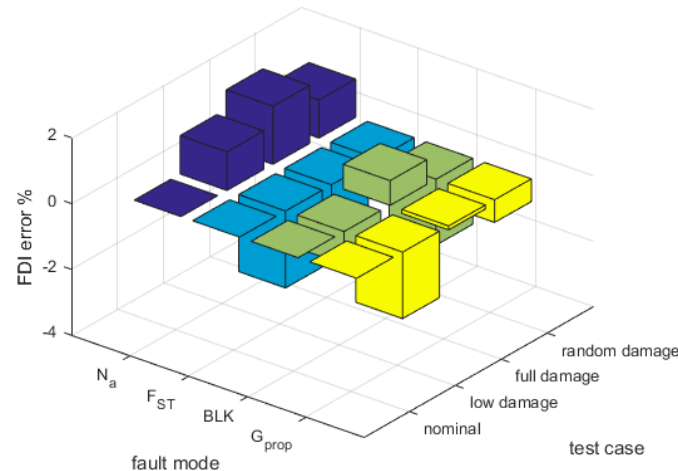
Figure 6. Bar plot of the fault identification error.